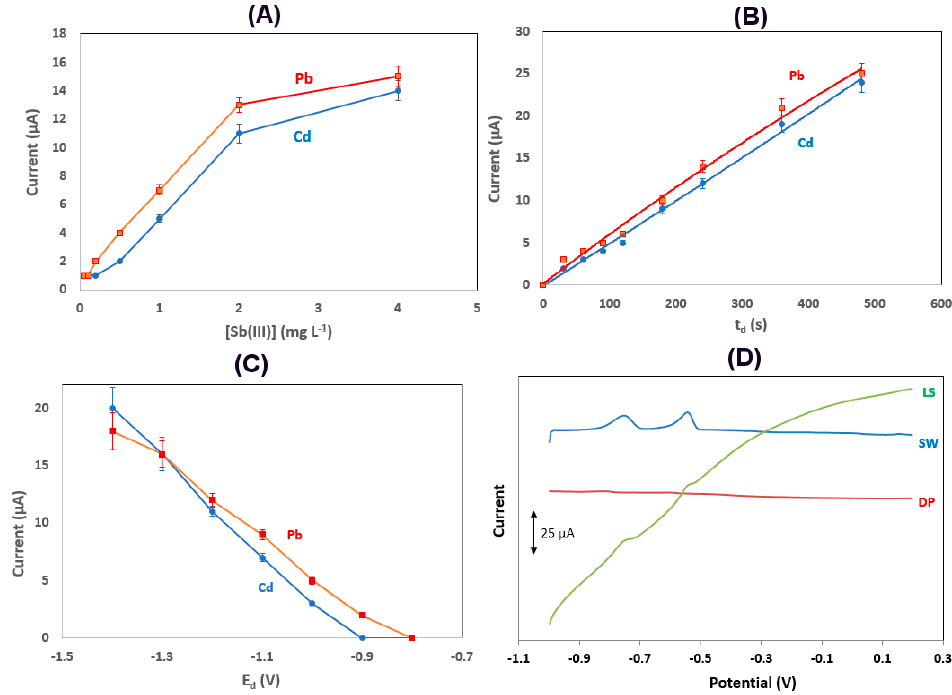
Figure 4. Study of ( A ) the Sb(III) concentration; ( B ) the deposition time; ( C ) the deposition potential; ( D ) the voltammetric scan waveform (voltammograms are o ff set for clarity). Conditions: 25 µ g L − 1 of Cd(II) και Pb(II); Sb(III) concentration, 20 mg L − 1 ; supporting electrolyte, 0.01 mol L − 1 HCl; deposition potential, − 1.2 V; deposition time, 240 s.